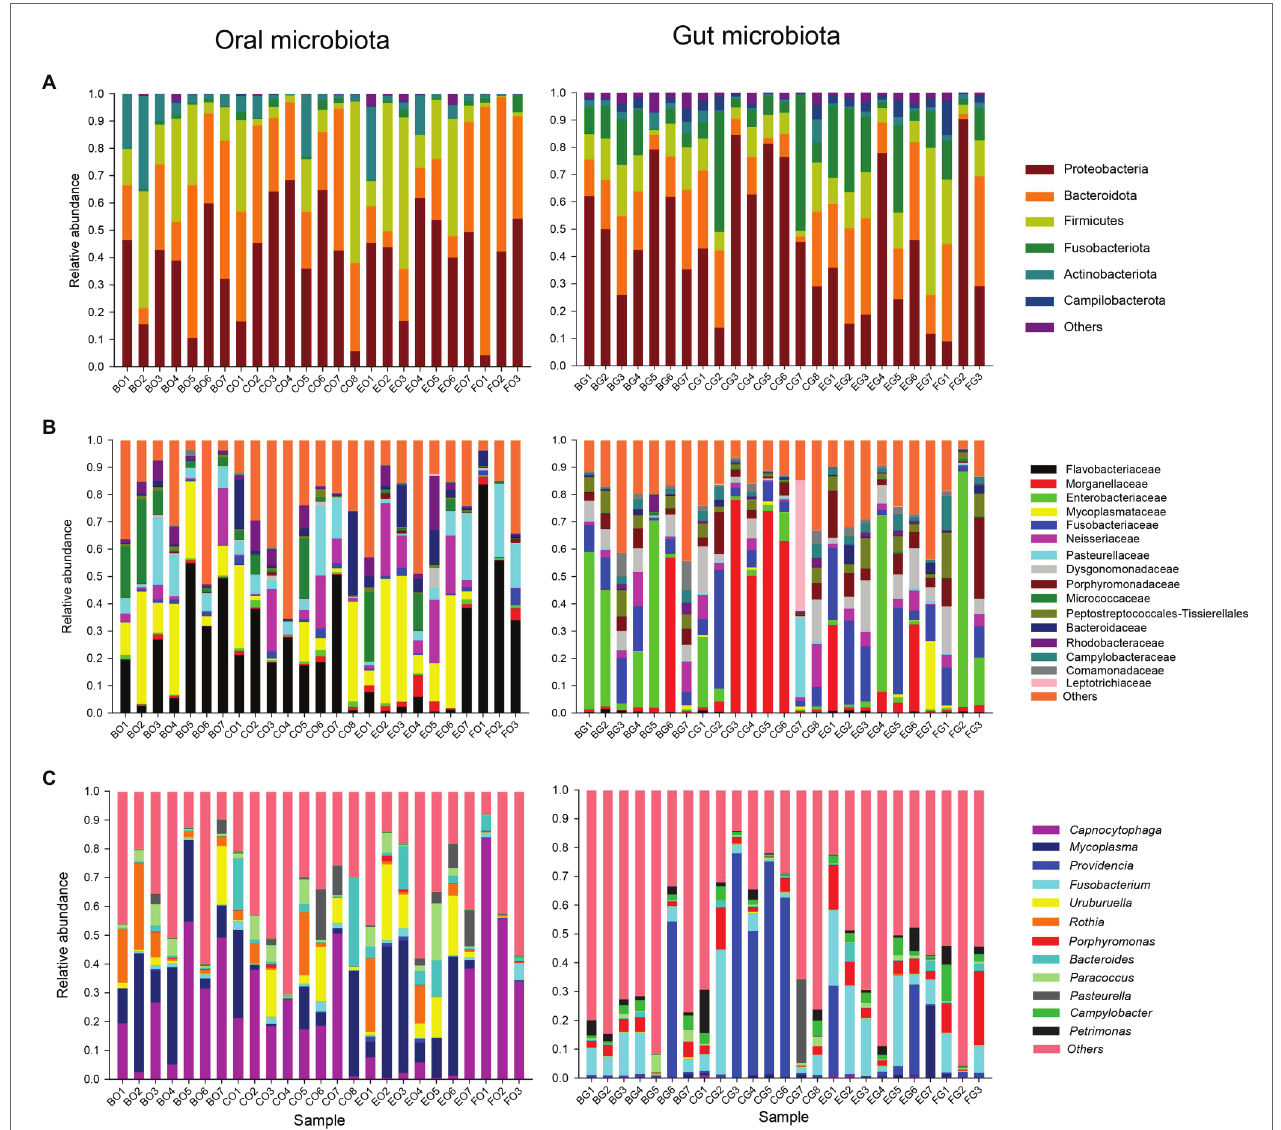
FIGURE 1 | The relative abundance of the oral and gut microbiota in each group at the phylum (A) , family (B) , and genus (C) levels. Each color in a plot represents a taxonomic group, of which the name is shown on the right side of the plot. The color for “others” indicates all other phyla (A) , families (B) , or genera (C) combined, of which the names are not listed in each plot. The first letter in each group indicates the item of food, such as B for bullfrogs, C for depilated chicken, E for eggs, and F for wild prey. The second letter in each group indicates a type of microbiota, G for the gut microbiota, and O for the oral